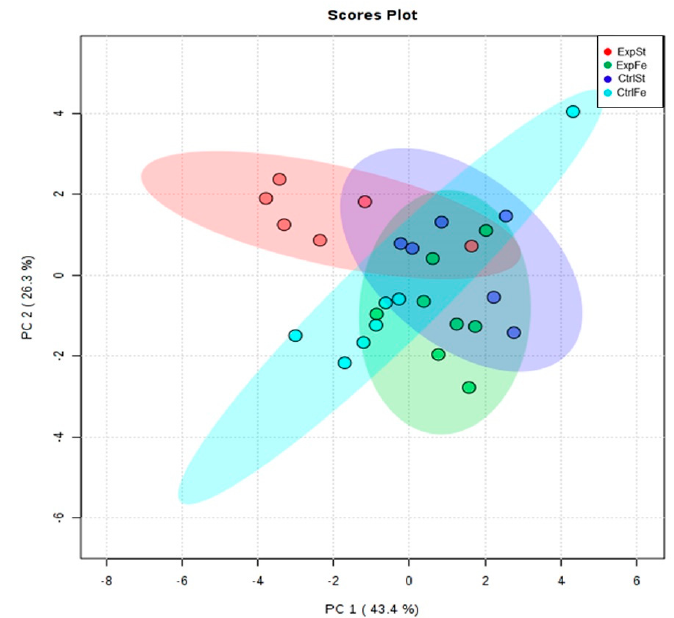
Figure 7. The Principal Component Analysis performed on four groups—rats on the standard diet with LNCaP (red dots—ExpSt); rats on the standard diet without LNCaP (blue dots—CtrlSt); rats with Fe supplementation with LNCaP (green dots—ExpFe); rats with Fe supplementation without LNCaP (light blue dots—CtrlFe).